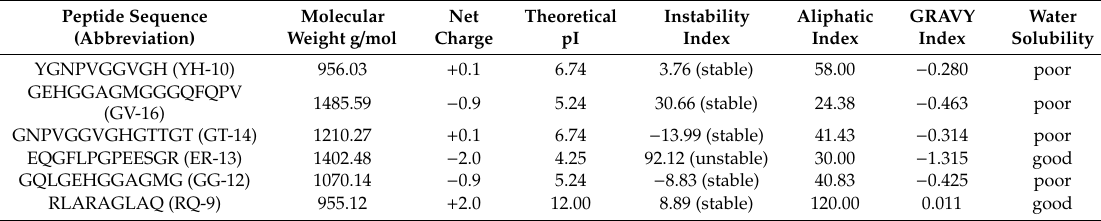
Table 1. Physicochemical characteristic of peptides. GRAVY: grand average of hydropathicity.